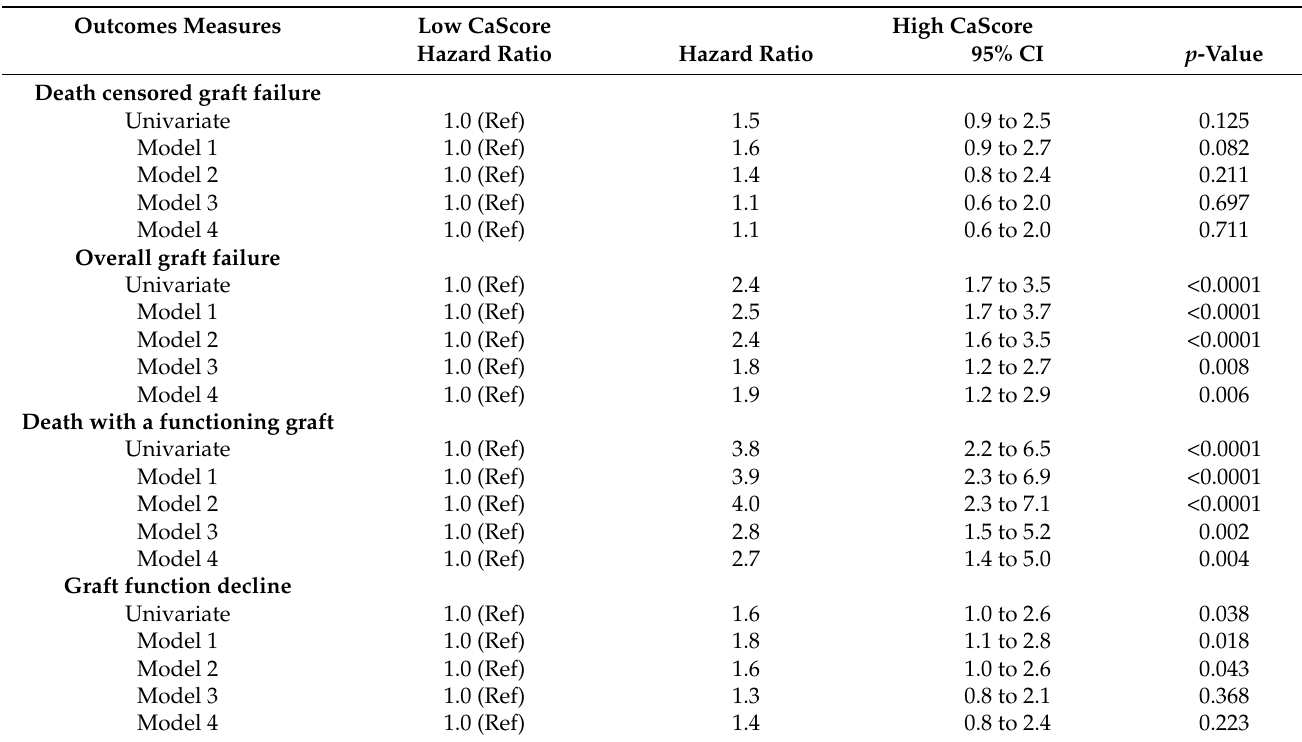
Table 4. Multivariable adjusted associations of the CaScore with (death-censored) graft failure, death with a functioning graft and graft function